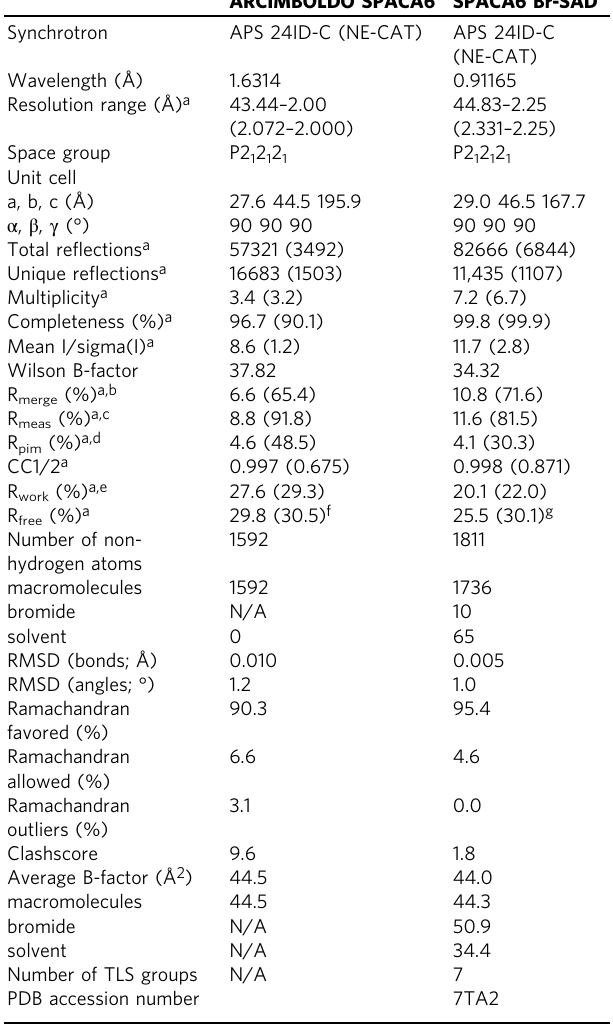
Table 1 Data collection and re fi nement